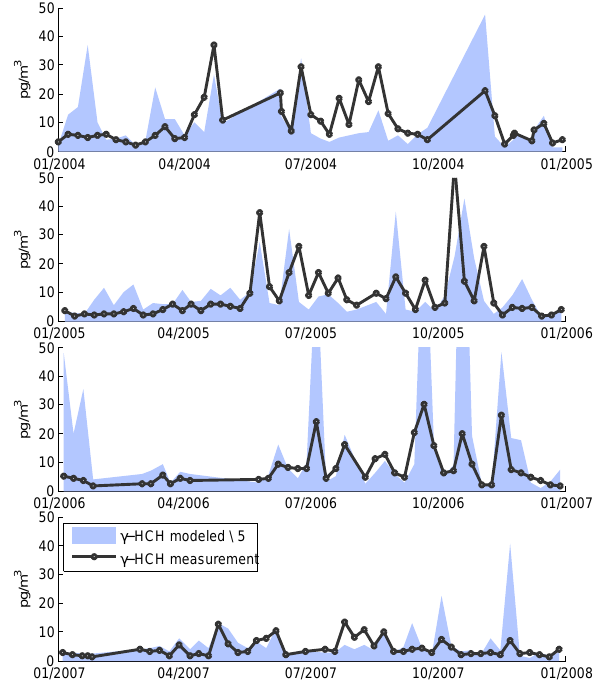
Fig. 6. Time series of modeled γ -HCH (blue) [pgm − 3 ] divided by 5 as well as measured γ -HCH (circles and